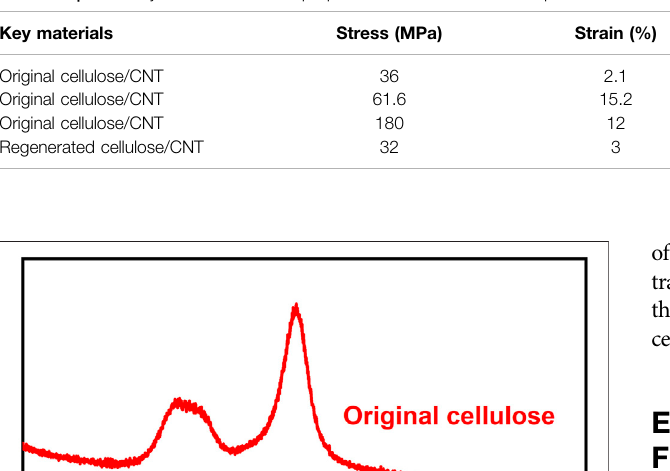
Frontiers in Energy Research |